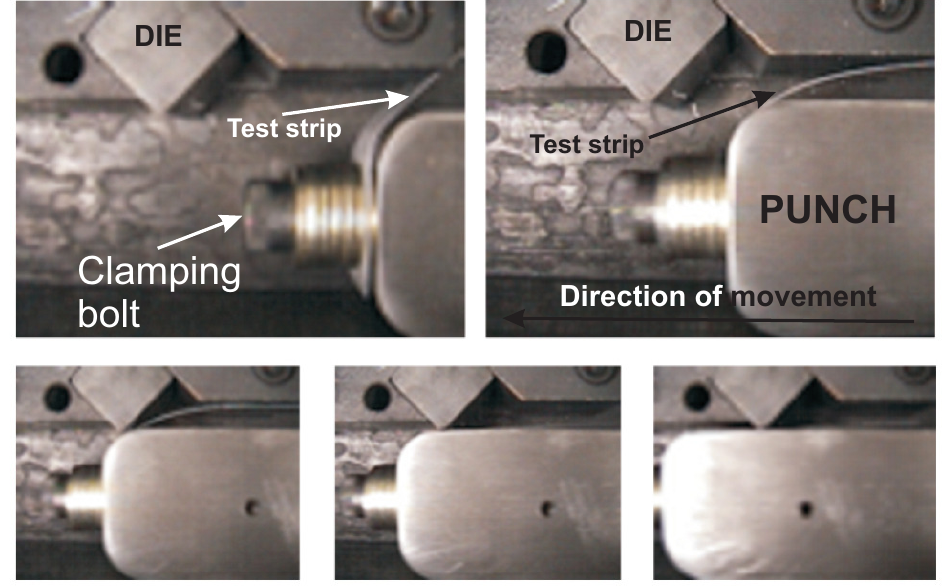
Figure 5. Five frames showing the exact moment when the ironing simulator irons a